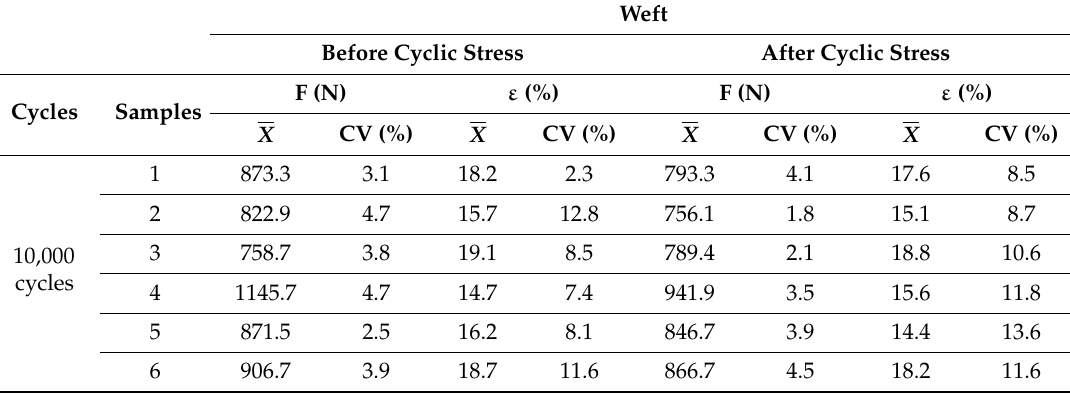
Table 4. Breaking force and elongation at break of samples in weft directions, before and after subjection to cyclic